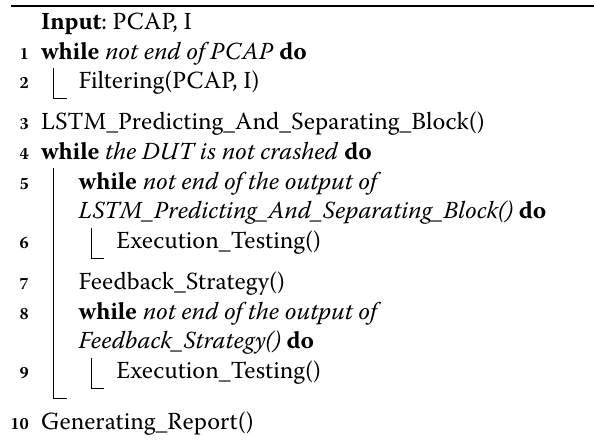
Automatic generating